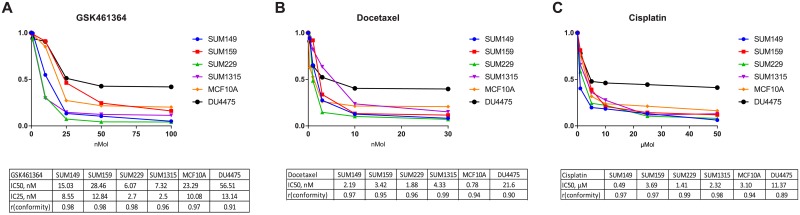
TNBC cell lines have diverse sensitivity to Plk1 inhibition and chemotherapy.TNBC cell lines: SUM149, SUM159, SUM229, SUM1315 and DU4475 cells, and the non-tumorigenic human breast epithelial cell line MCF10A. TNBC cell lines were treated for 72 hours in triplicates. Three replicate data were performed for each concentration and the best dose–response model (r conformity closest to 1) was selected and graphed. After a 72 hours exposure to drug, cell number was determined by harvesting and counting nuclei with a Beckman Coulter Z1 Particle Counter. IC50, IC25, and r conformity were determined using CompuSyn software. (A) Sensitivity to GSK461364, Plk1 inhibitor, in TNBC cell lines; IC50, IC25, and r conformity were reported for GSK461364. (B) TNBC cell lines sensitivity with respective IC50 and r conformity to docetaxel. (C) TNBC cell lines sensitivity with respective IC50 and r conformity to cisplatin.